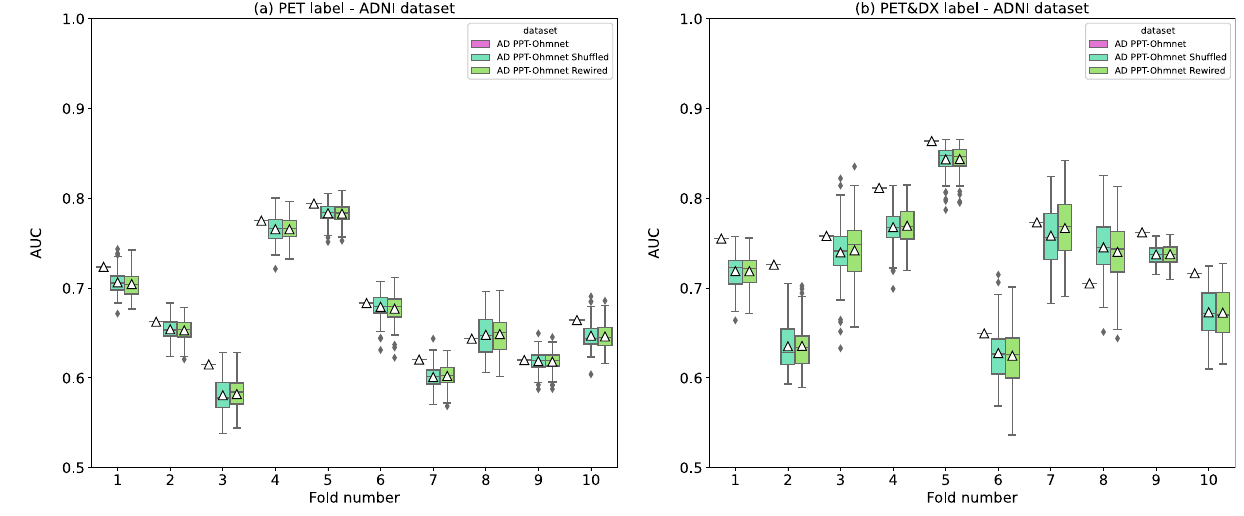
Figure 4. Boxplots showing the distribution of AUC values over the ten different test sets (ten different folds) using (i) the original AD PPT-Ohmnet dataset (pink), (ii) 100 different “shuffled” datasets (light blue), and (iii) 100 different “rewired” datasets (light green). White triangles ( △ ) represent mean AUC values. Asterisks (*) represent a p-value < 0.05 (Benjamini–Hochberg correction) obtained by comparing original graph datasets’ performance vs. random graph datasets’ performance. Boxplots were obtained for ( a ) PET and ( b ) PET&DX labelings using the ADNI